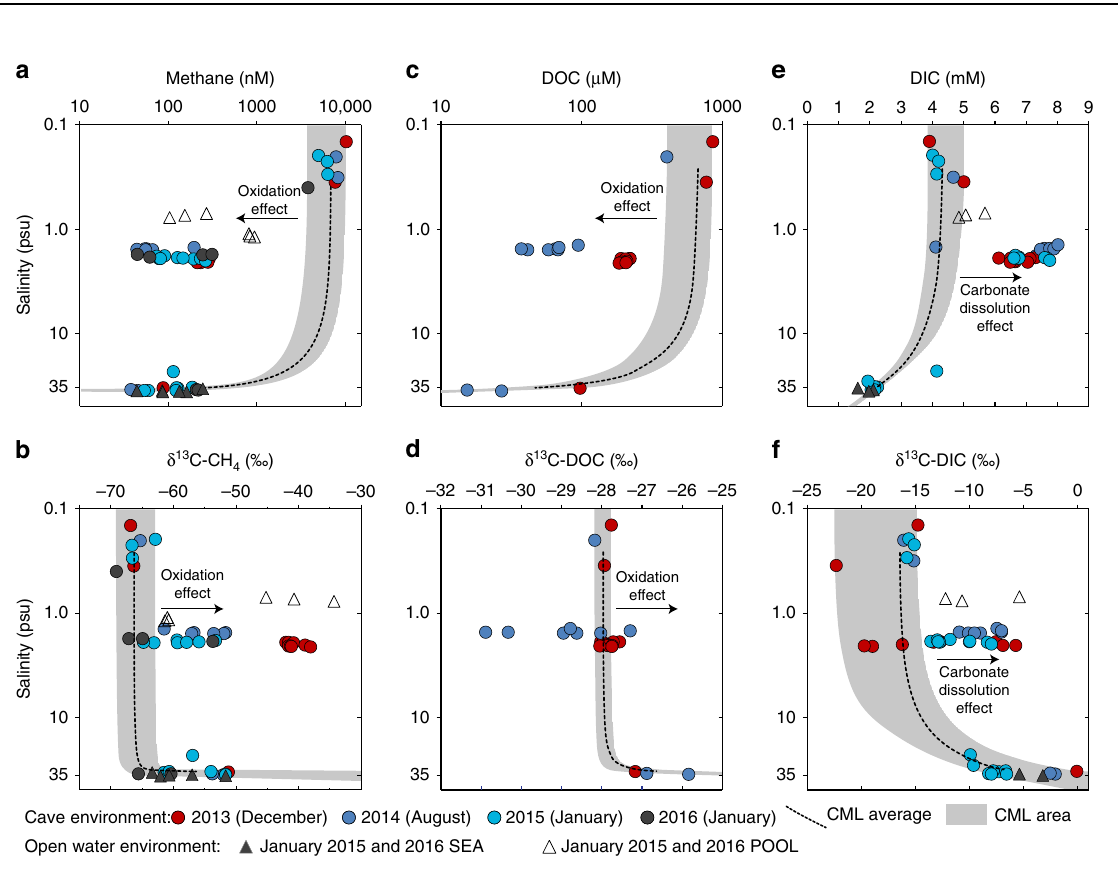
Fig. 3 Plots of salinity vs. chemical properties from the subterranean estuary. a Methane concentrations. b Dissolved organic carbon (DOC) concentrations. c Dissolved inorganic carbon (DIC) concentrations. d Methane stable carbon isotopic ( δ 13 C) values. e DOC stable carbon isotopic ( δ 13 C) values. f DIC stable carbon isotopic ( δ 13 C) values. The average and total area of conservative mixing lines (CMLs; see Methods for calculations) represent the trend predicted by the mixing model if there was only physical mixing between the meteoric freshwater and saline groundwater end members. Production yields an excess of the constituent relative to the CML average and area, while consumption results in depletion. Symbol of individual data points contain the uncertainty (1 std. dev.) of the measured Supplementary Fig. 2). The MFW δ 13 C-DOC values ( − 28.0 ±